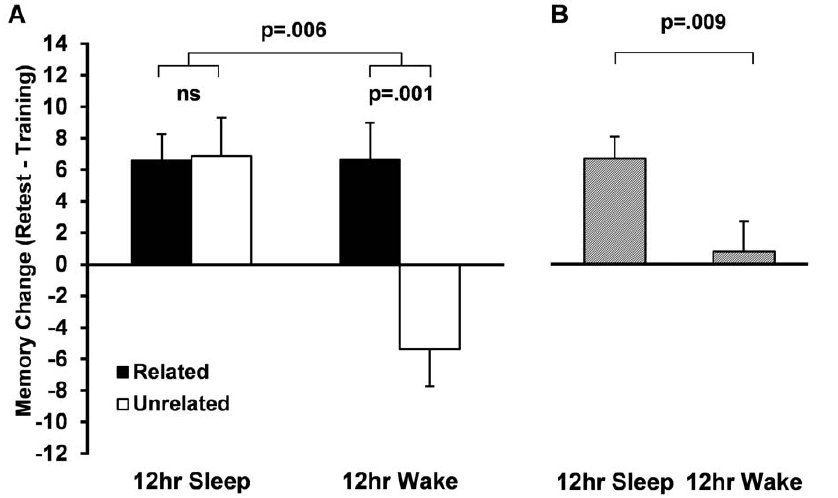
Figure 2. 12 hr Performance Data. A. Change in recall from training to retest for Related (black bars) and Unrelated (white bars) word pairs in the 12 hr Sleep and Wake groups. B. Data collapsed across word pair type (striped bars). Bars represent % recall at training minus % recall at retest (means 6 SEMs).